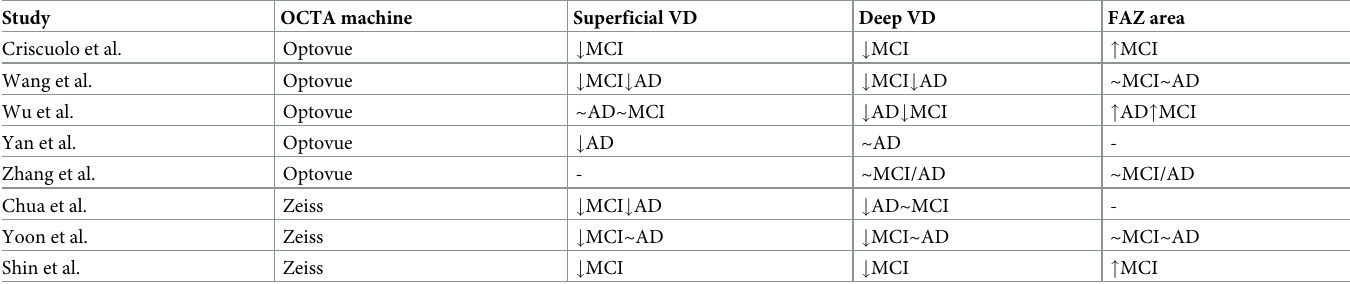
Table 2. Measurements that were included 8 studies are shown, each study was identified by using either the Optovue or the Zeiss OCTA machines.